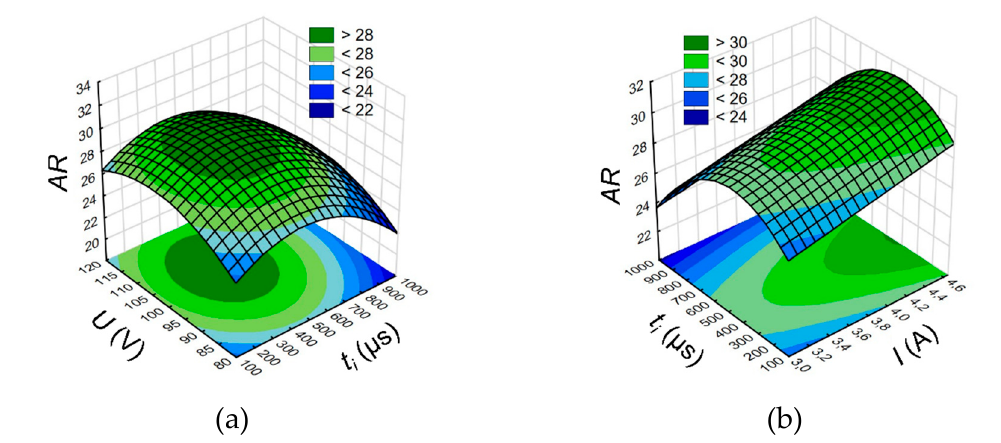
Figure 8. ( a ) Relationship between the aspect ratio AR and the pulse time t i and ( a ) discharge voltage amplitude U , I = 3.83 A and ( b ) current amplitude I , U = 100 V.